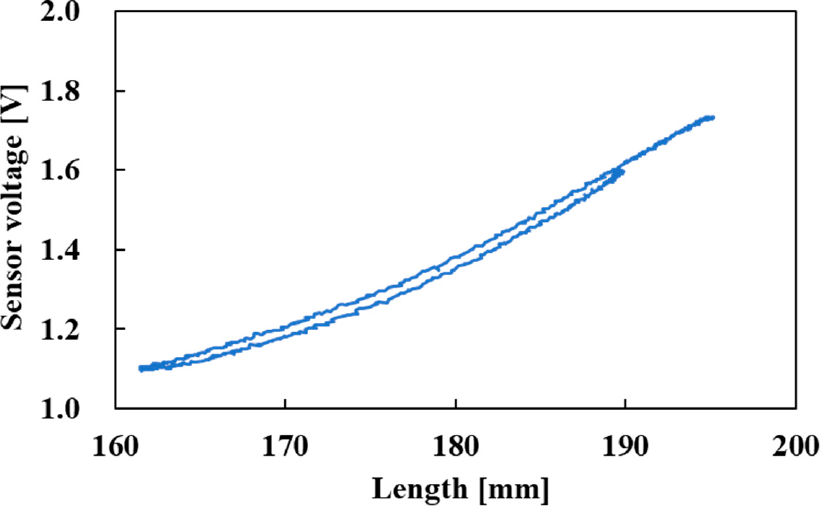
Figure 15. Relationship between length and sensor voltage (pneumatic pressure: 0.0 MPa → 0.3 MPa → 0.0 MPa, then held until 120 s).